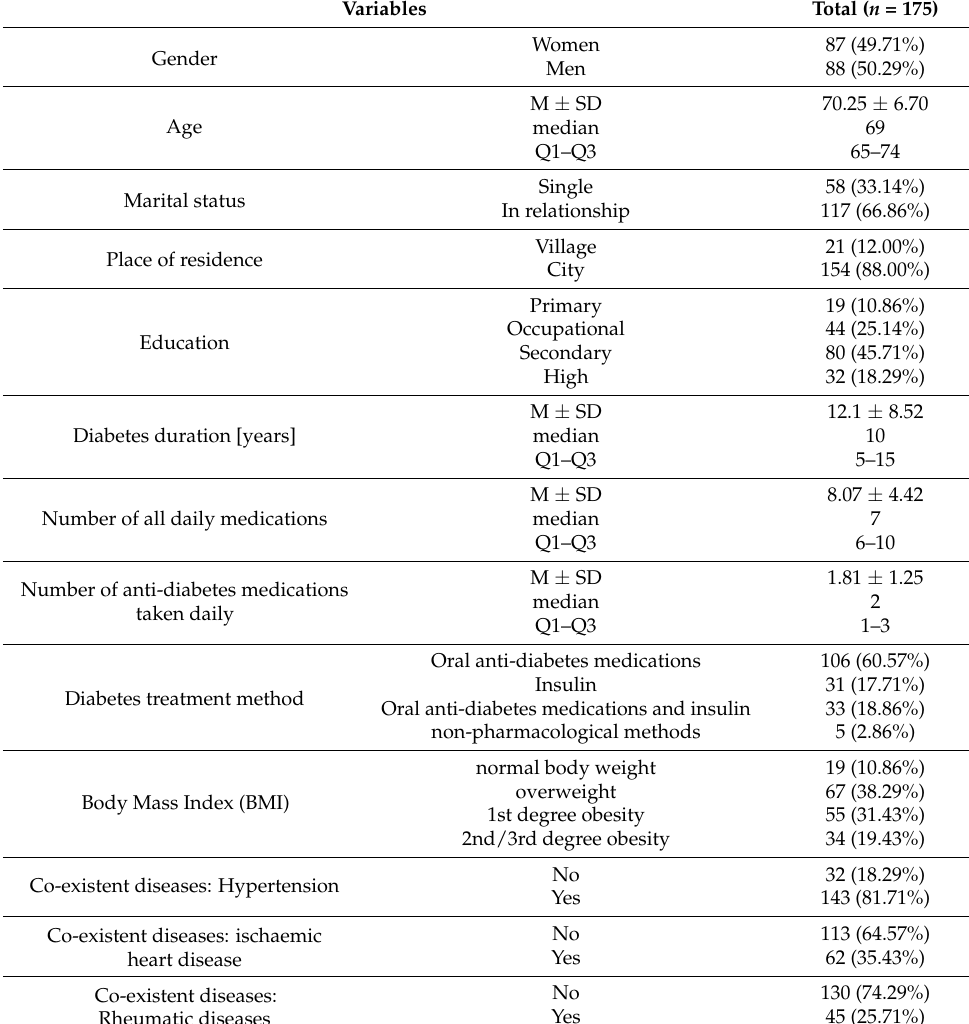
Table 1. Socio-demographic and clinical characteristics of the sample